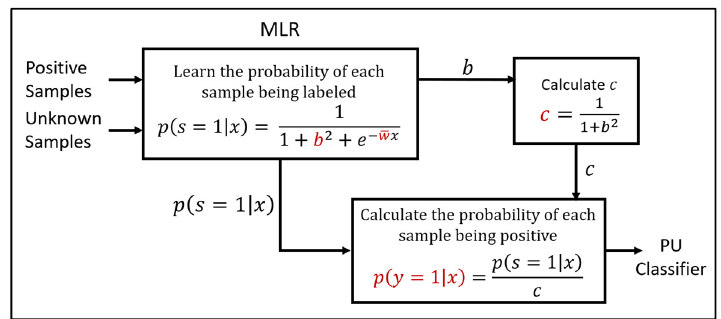
Figure A1 A block diagram of the MLR algorithm. Figure A1. A block diagram of the MLR algorithm. Table A1. This table provides the raw results for Figure 2 and their variance. Shaded vs. All